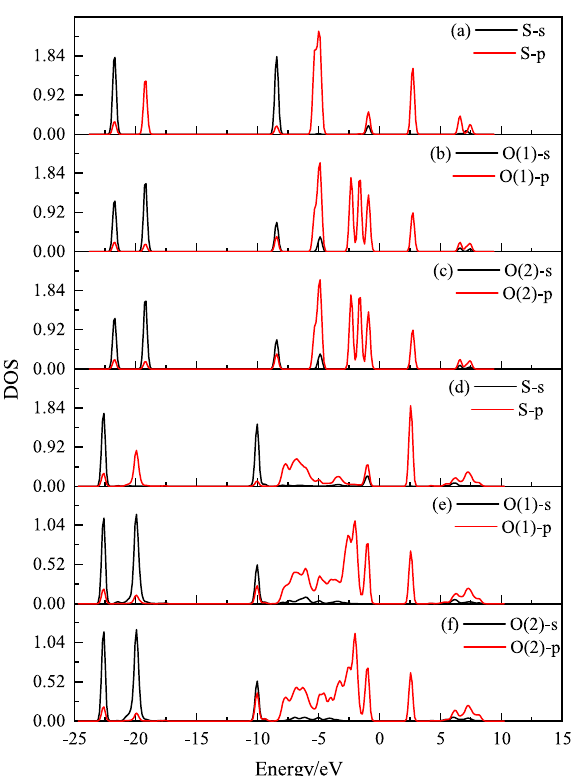
Figure 6. The change about orbital-resolved partial DOS for S and O atoms in SO 2 molecular after adsorption. ( a – c ) respectively represent orbital-resolved partial DOS for S, O(1), and O(2) atoms in SO 2 before adsorption; ( d – f ) respectively represent orbital-resolved partial DOS for S, O(1), and O(2) atoms in SO 2 after